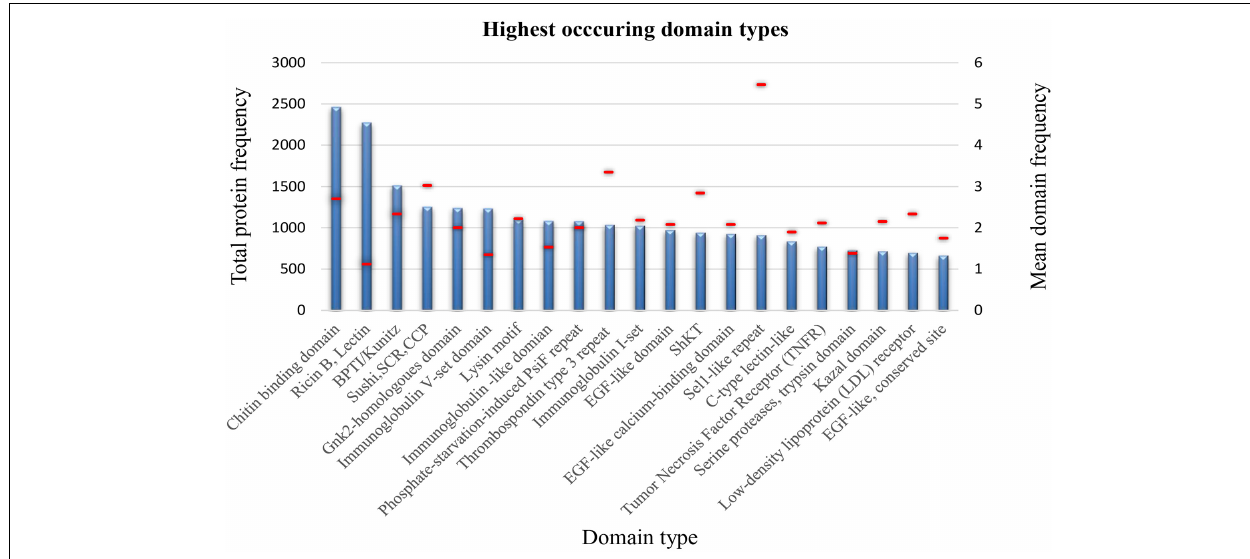
FIGURE 6 | SCREP structural diversity. Distribution of the 20 highest occurring domain types identified by InterPro within the refined SCREPs population, showing frequency of proteins within an individual domain type (blue), and the mean domain frequency (red line overlay).